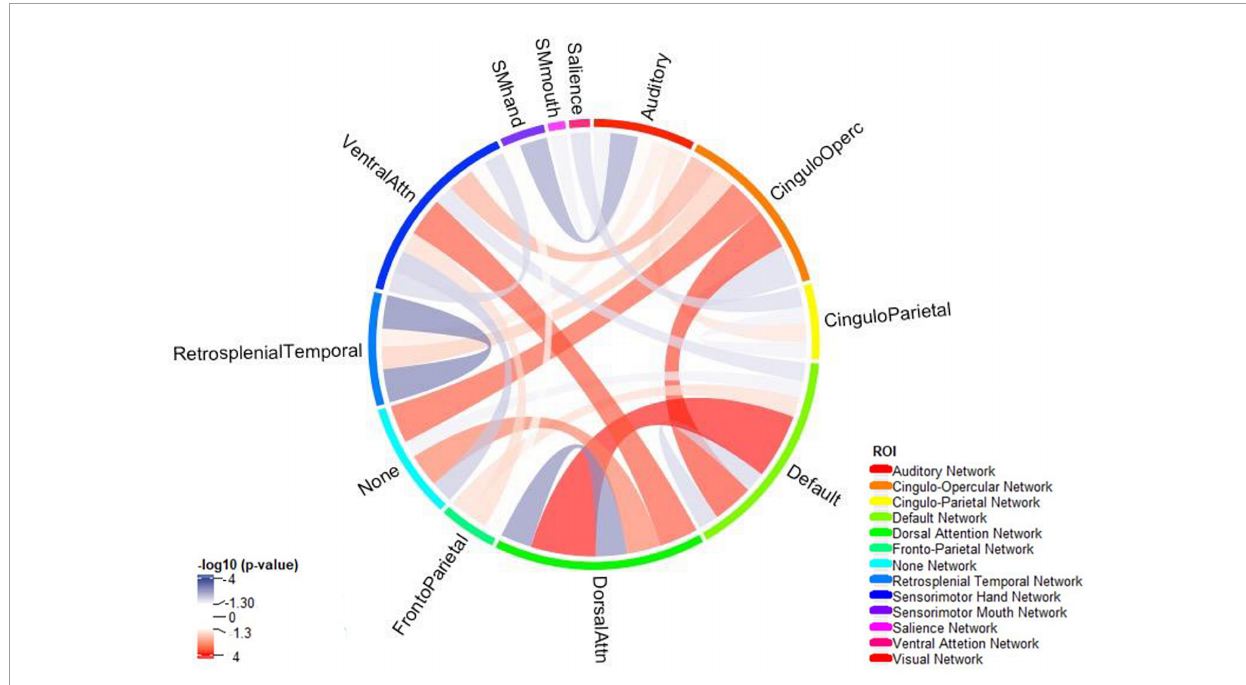
FIGURE4 The connectogram summarizes reduced (blue) and increased (red) network connectivity between functional areas among children with ADHD compared to those without – independent of age, biological sex, race, handedness, and highest parental education as a marker of socioeconomic status, and after correction for multiple comparisons. Functional network was split using Gordon